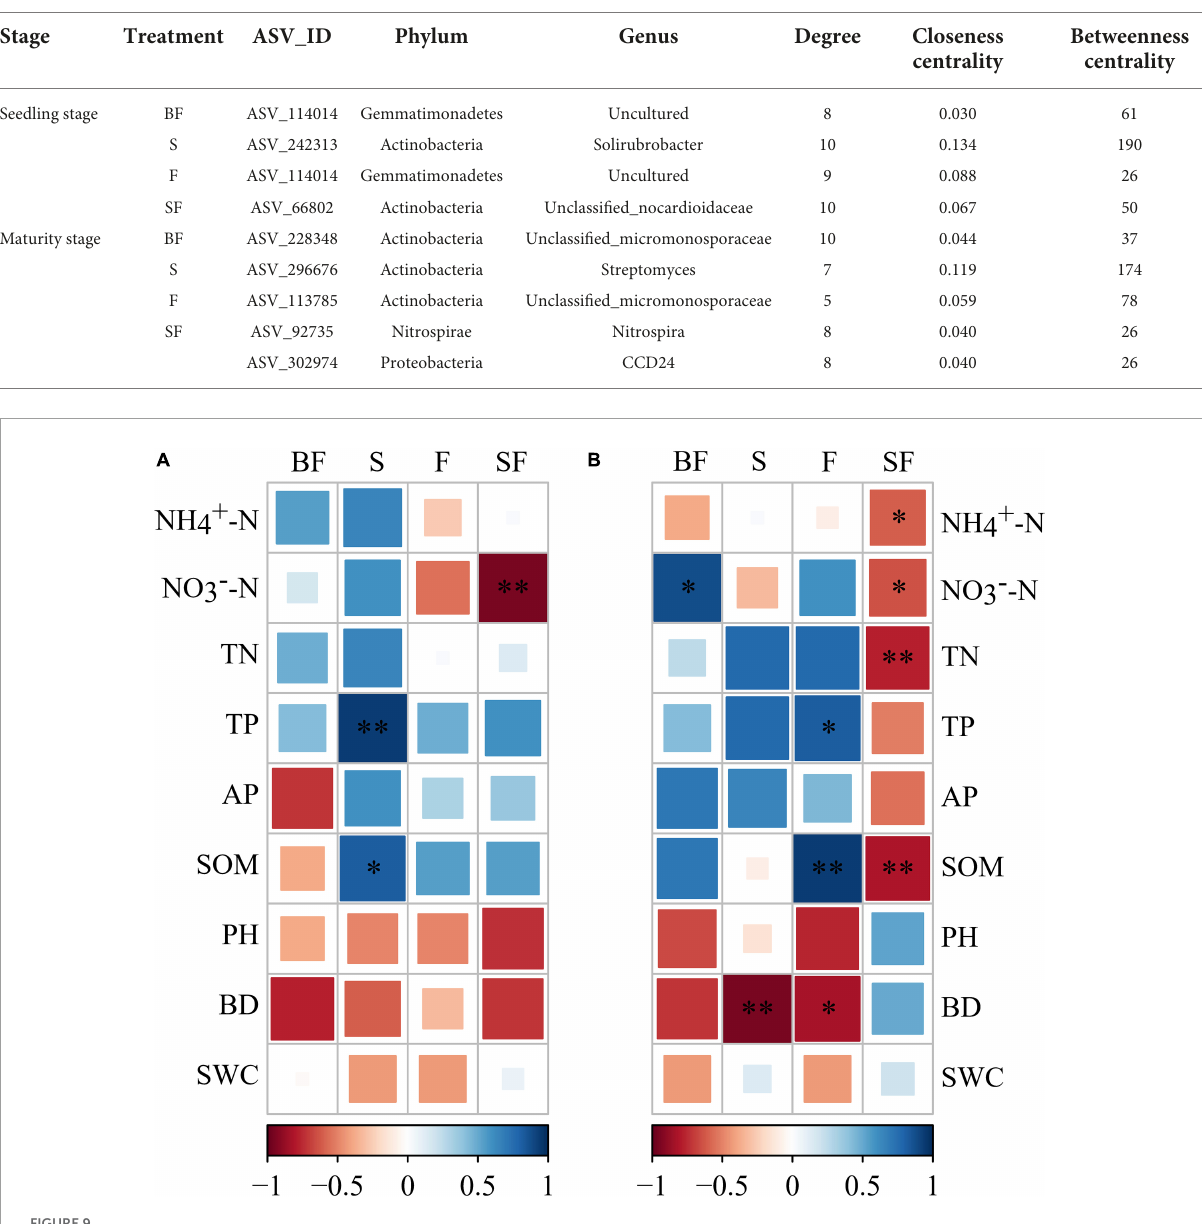
TABLE 4 The keystone taxa in bacterial networks under different treatments at different growth stages.